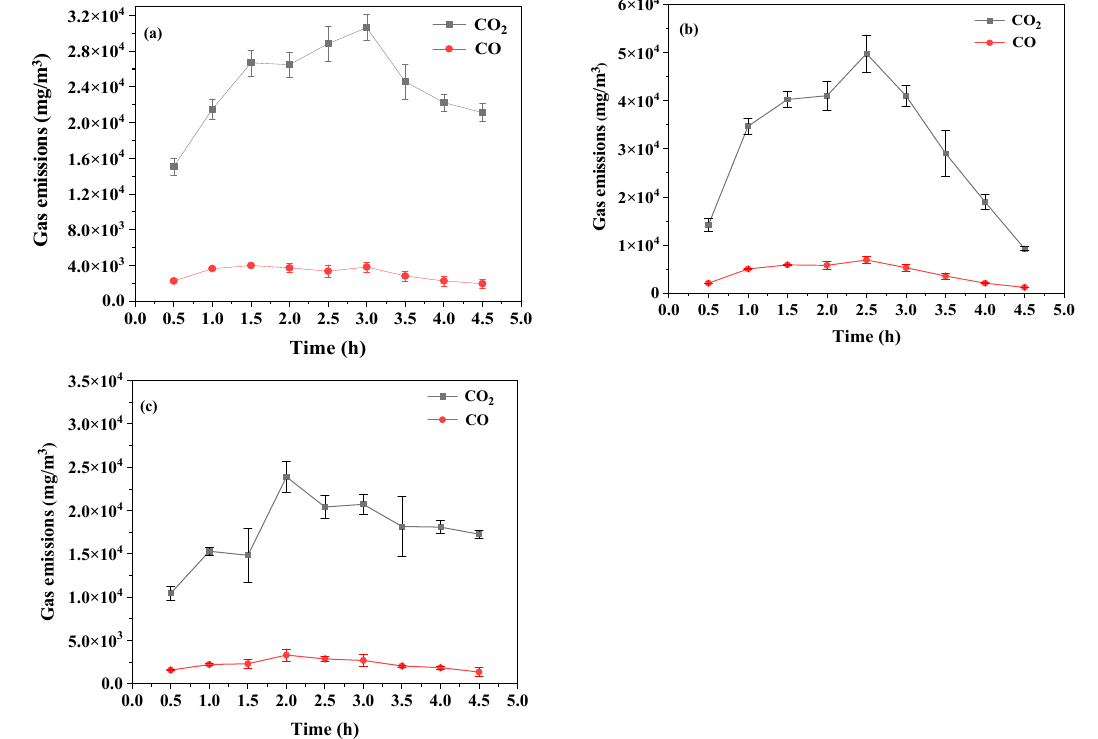
Table 2. The EF of PM from the smouldering combustion (g/kg).